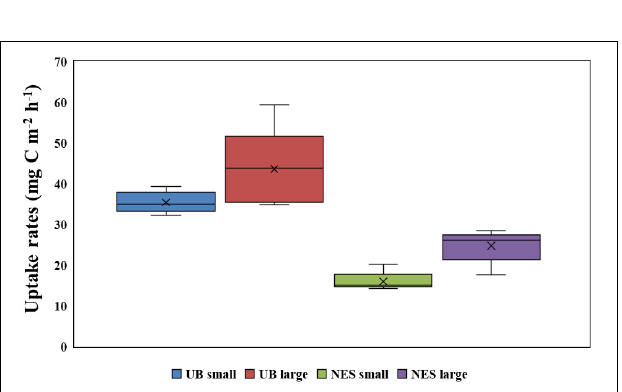
FIGURE 6 | Comparison of depth-integral carbon uptake rates for small and large size phytoplankton in the UB and NES.